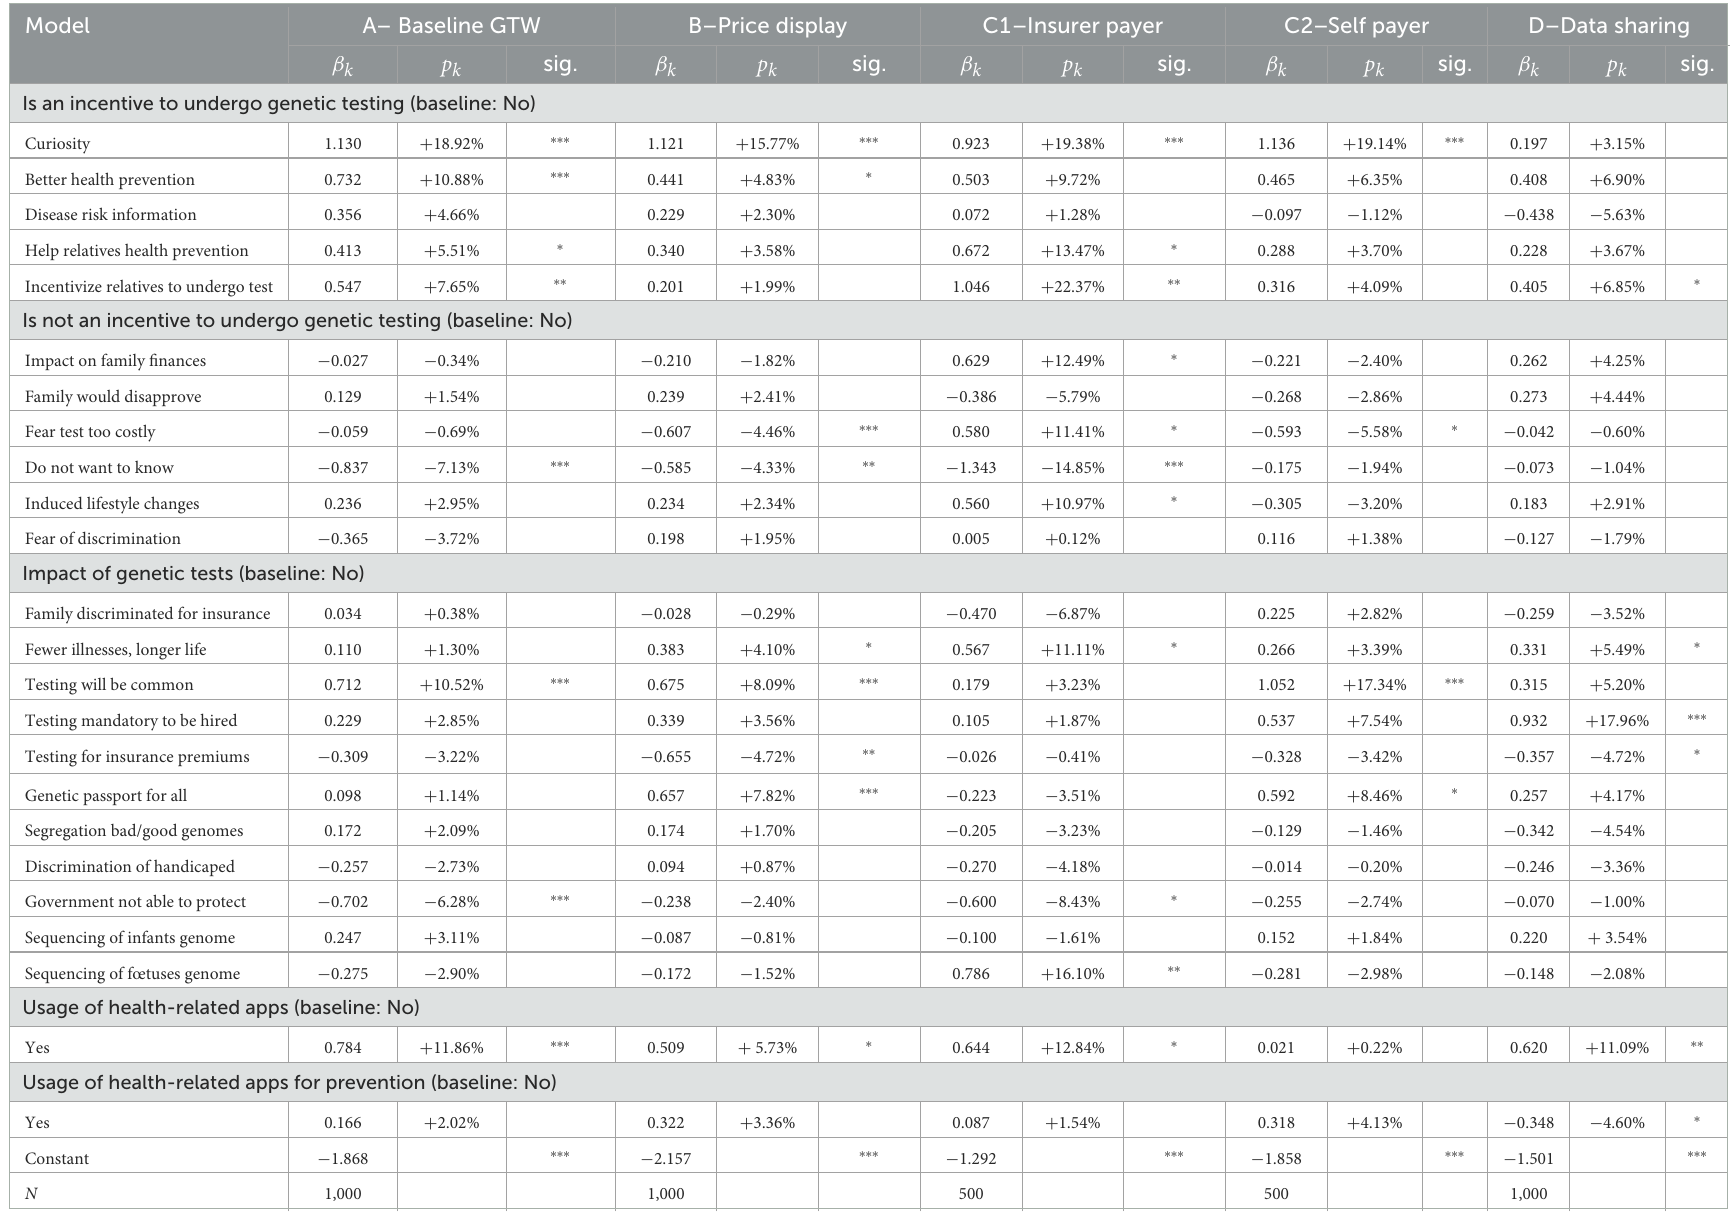
TABLE 9 Regression results for sentiment